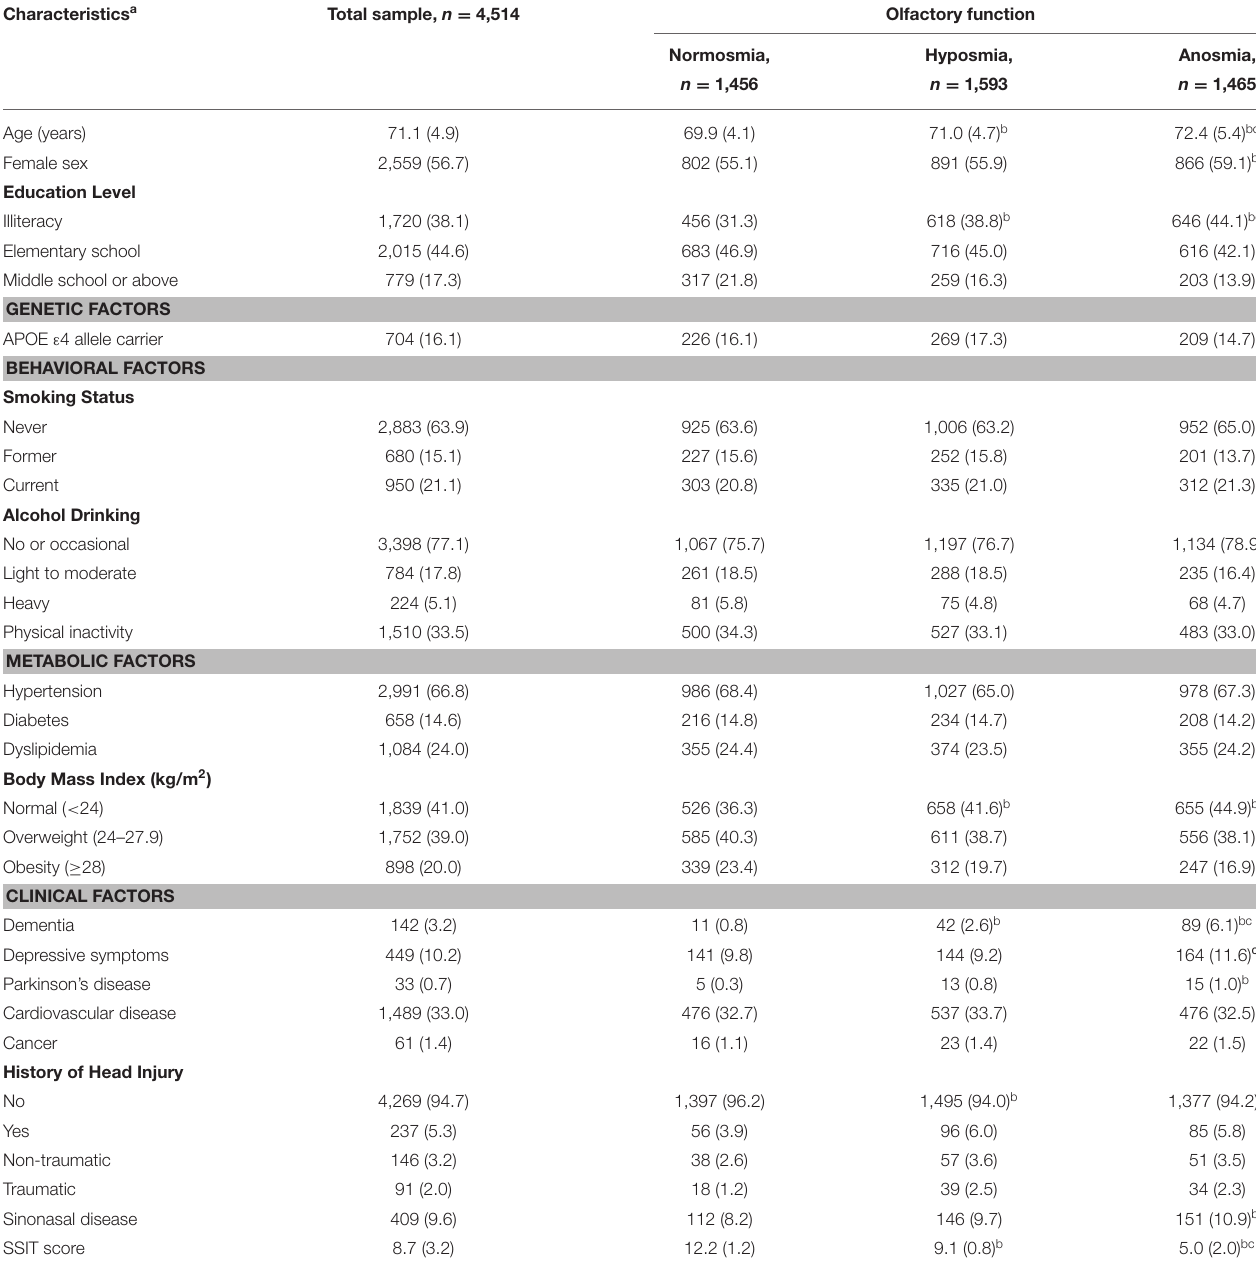
TABLE 1 | Characteristics of study participants by olfactory function. Characteristics a